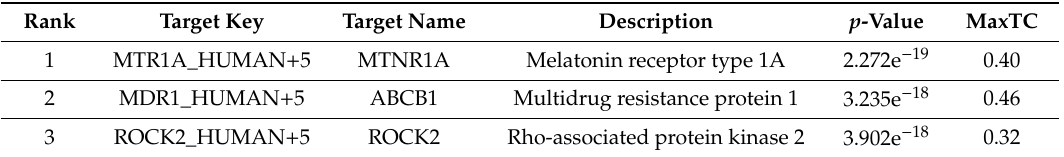
Table 1. Top three predicted human protein targets for compound 160a based on the similarity ensemble approach